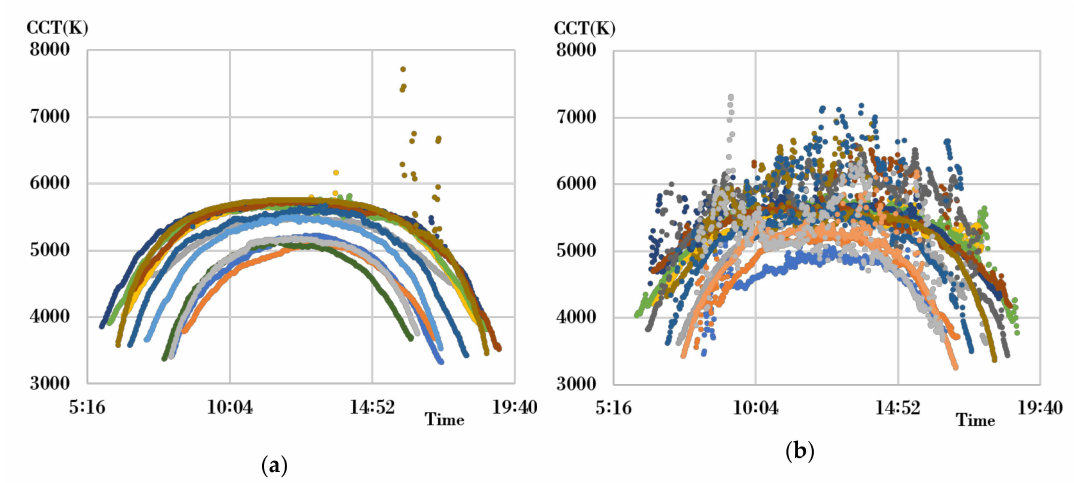
Figure 1. Hourly color temperature distribution of the experimentally tested natural light. ( a ) A clear day; ( b ) A cloudy day.